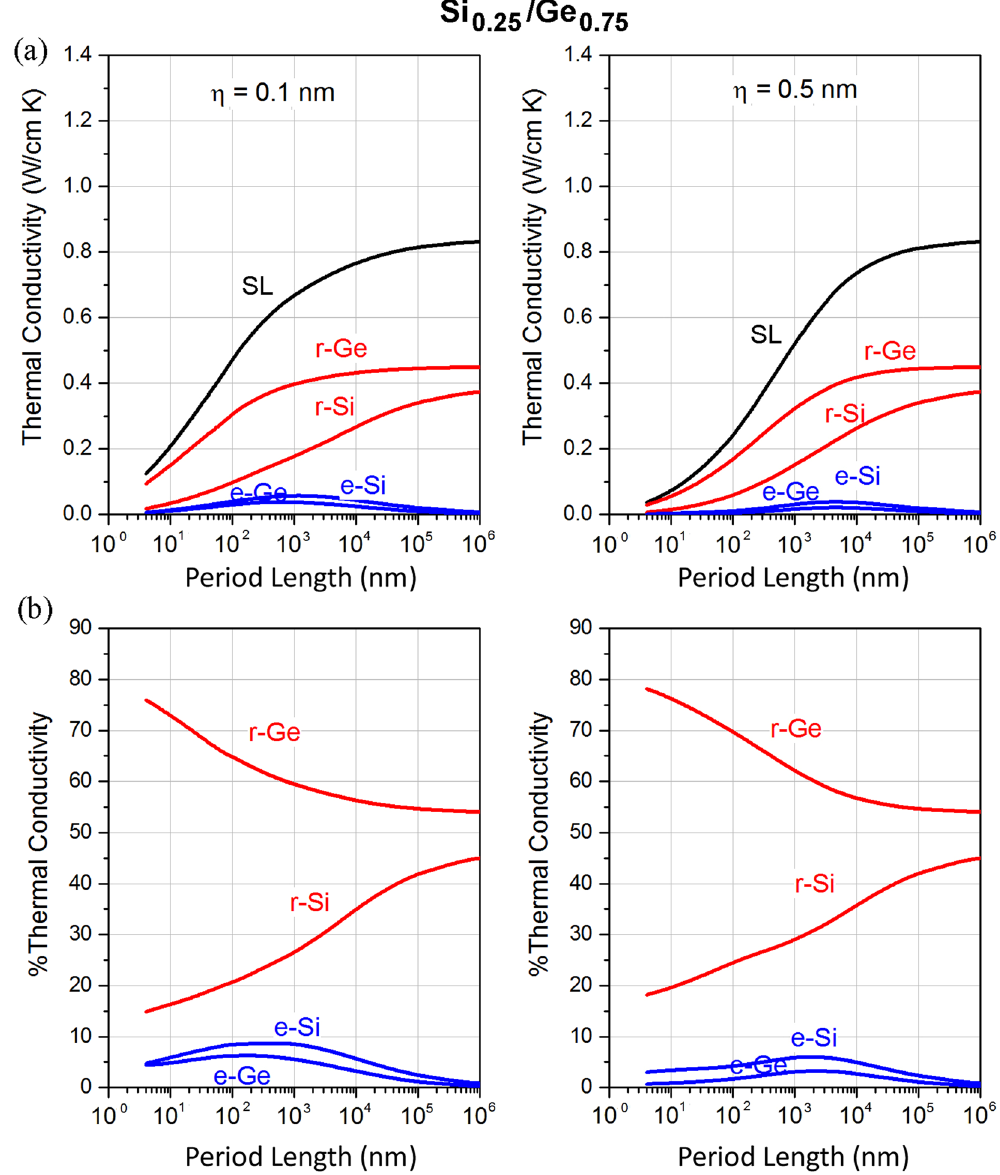
Figure 4. ( a ) Variation of thermal conductivities with period length for Si/Ge SLs, having volume fraction of f Si = 0.25, with surface roughness η = 0.1 nm and η = 0.5 nm. ( b ) Relative contribution of extended and layer- restricted